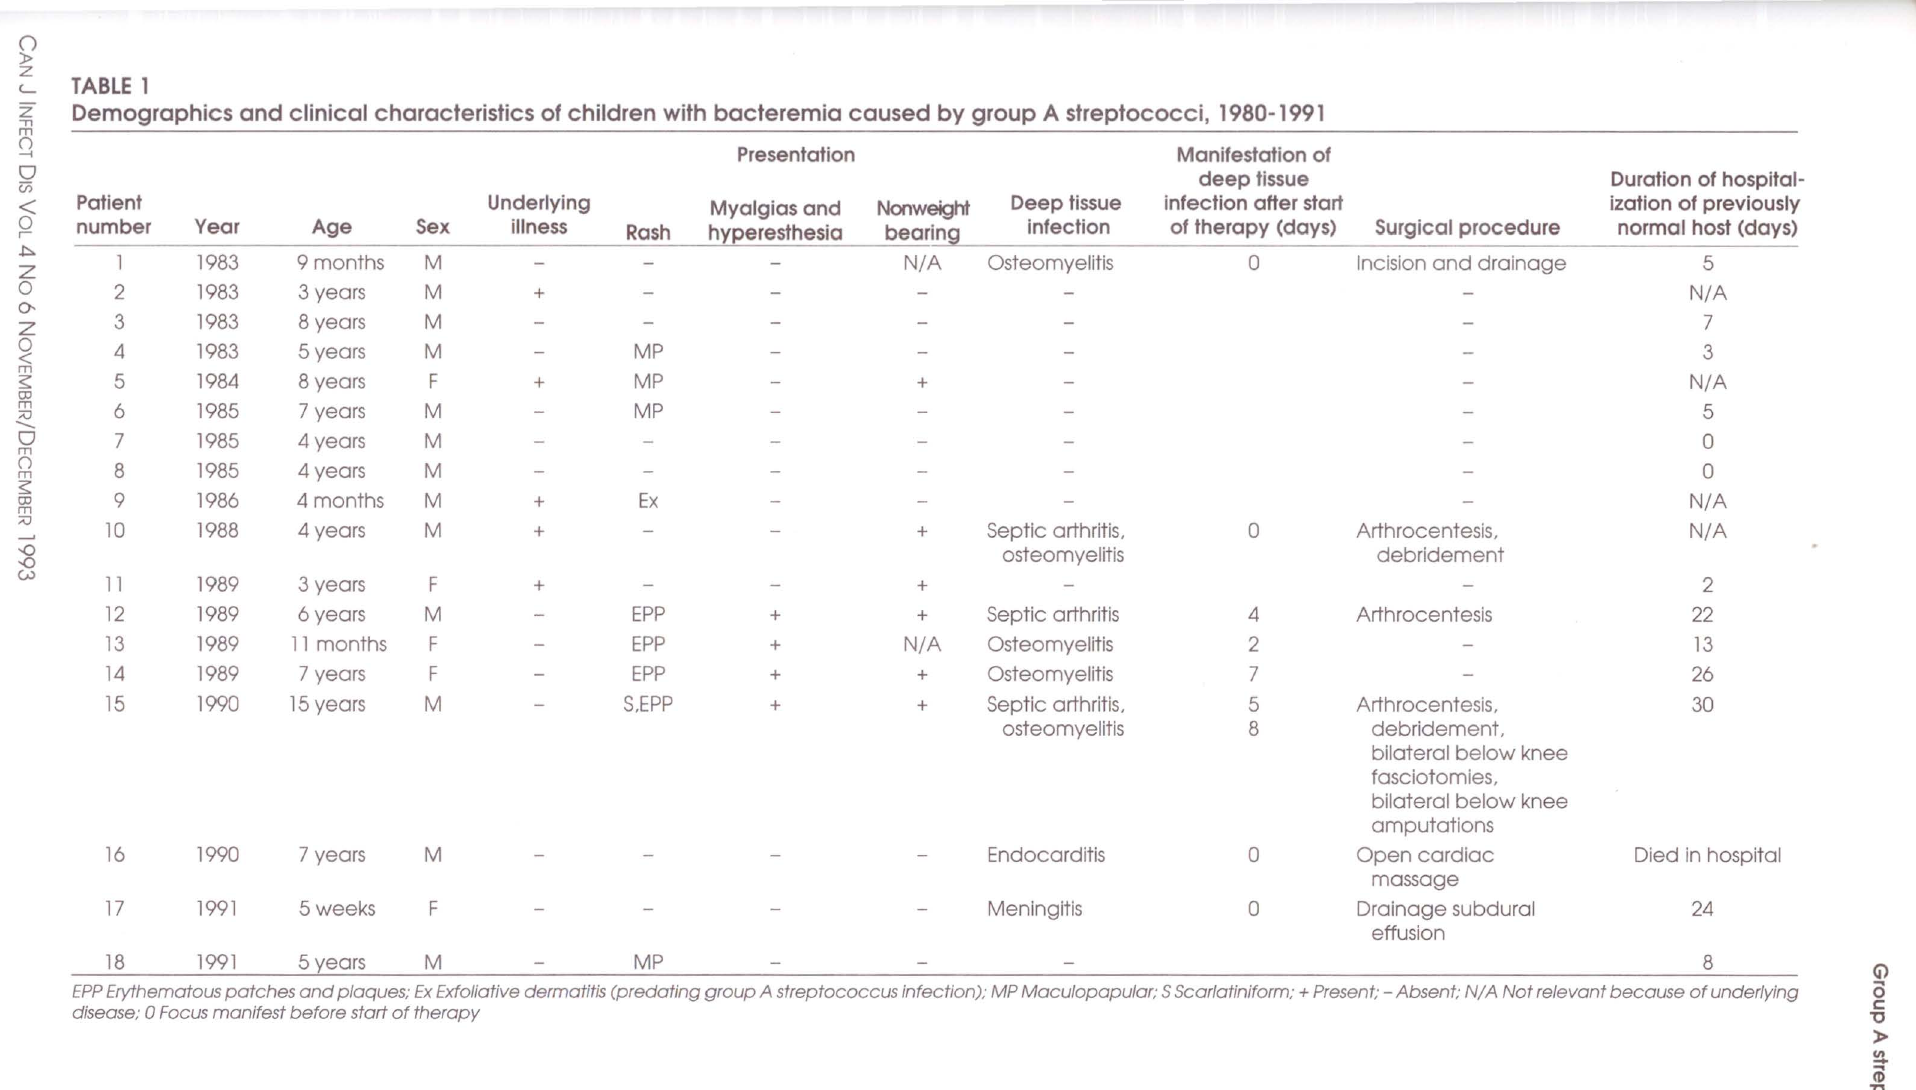
Demographics and clinical characteristics of children with bacteremia caused by group A streptococci, 1980-1